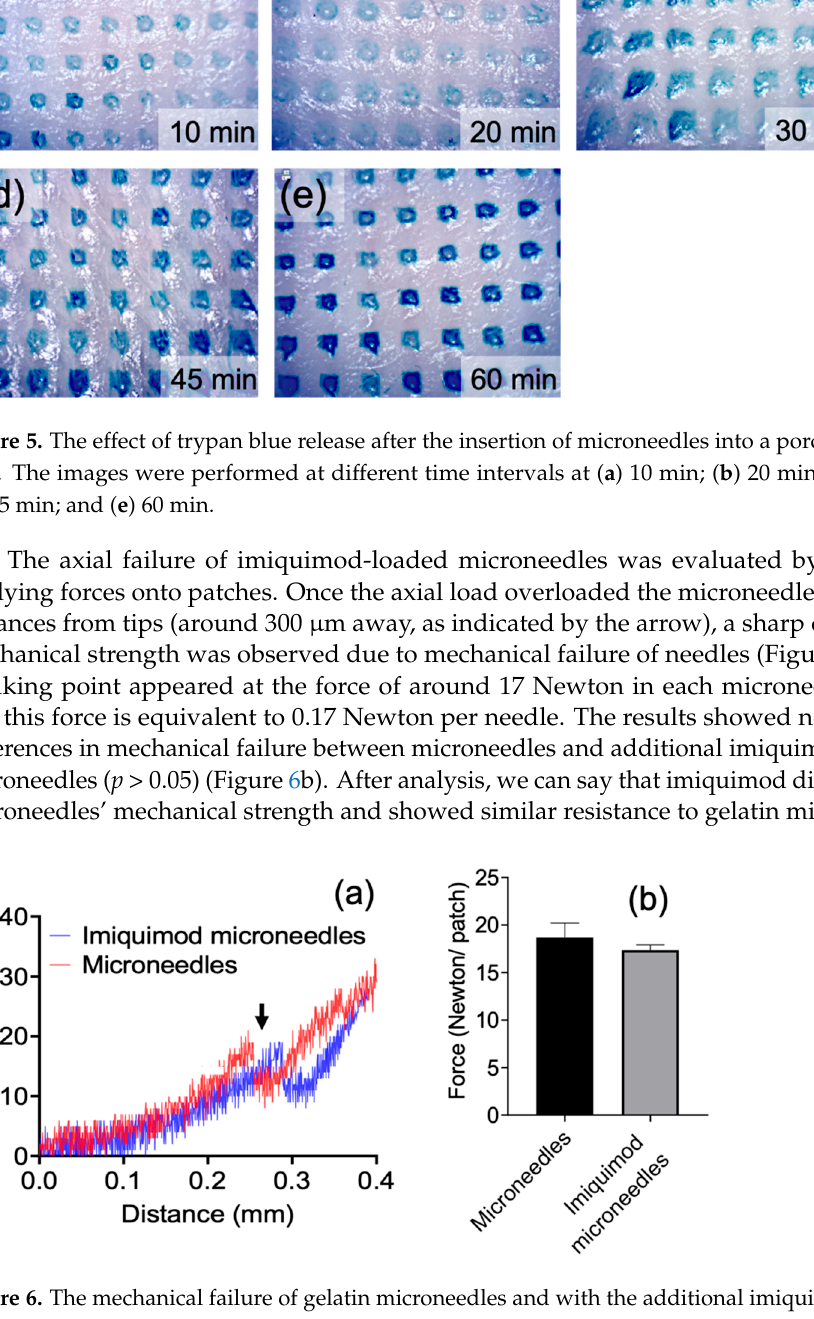
Figure 6. The mechanical failure of gelatin microneedles and with the additional imiquimod- loaded microneedles. The axial failure of imiquimod-loaded microneedles was evaluated by verti- cally applying forces onto patches. ( a ) the spectrum of microneedles’ mechanical strength; and ( b ) the failure force of microneedles.